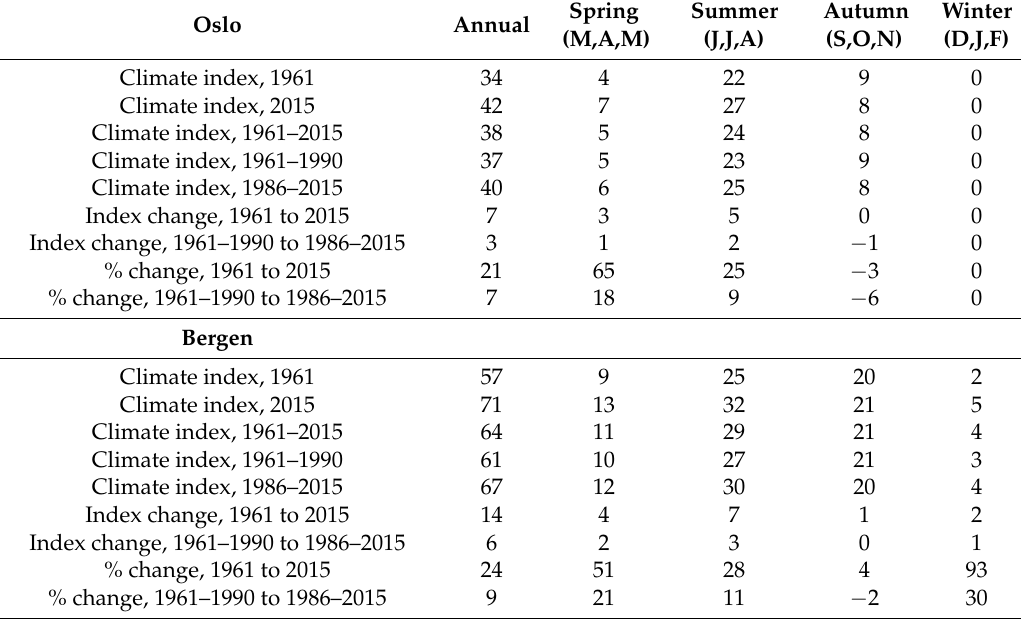
Table 1. The annual and seasonal average values and changes for the climate index over the period